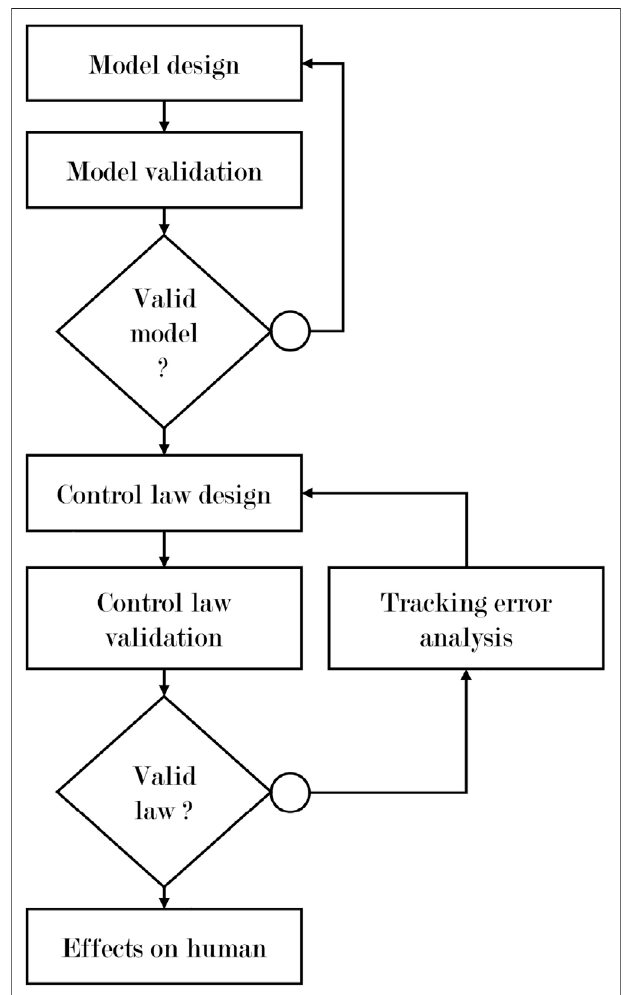
FIGURE 1 | Applied